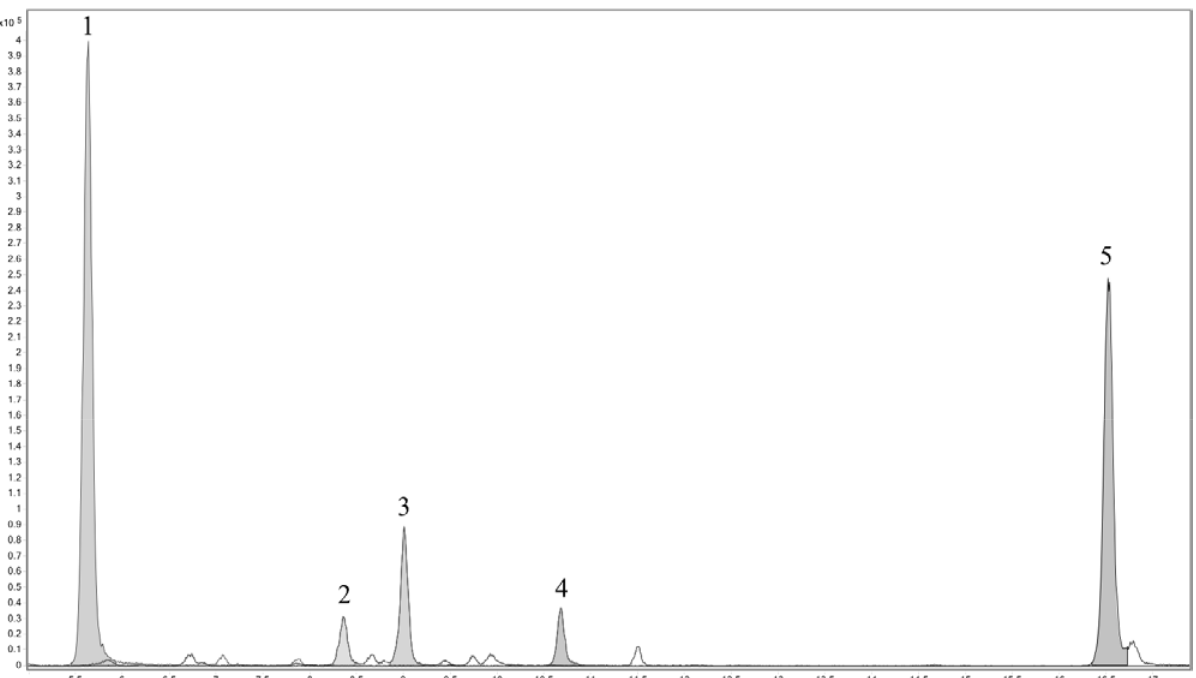
Figure 2. UHPLC/QTOF - Extract ion chromatogram of a symptomatic grapevine leaf extract prepared using the procedure selected (E2; see text). 1, trans -resveratrol; 2, cis -ε-viniferin; 3, trans -ε-viniferin; 4, trans -δ-viniferin; 5, trans -pterostilbene.